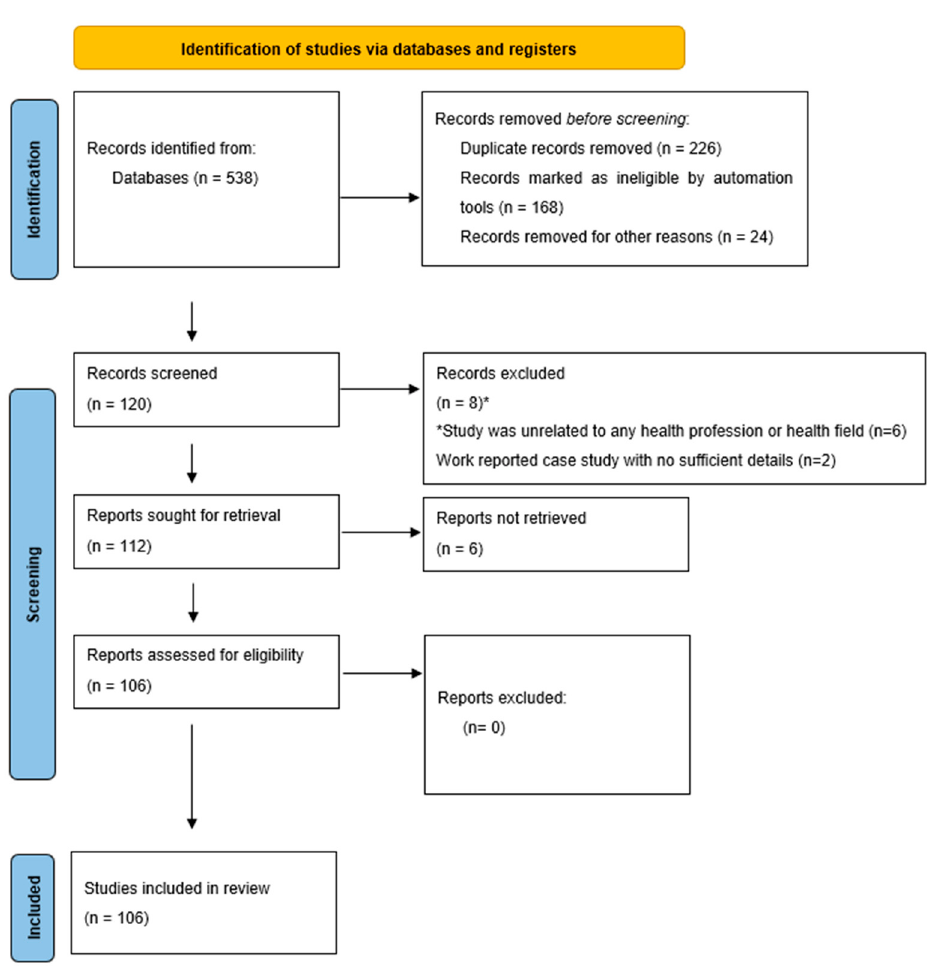
Figure 3. Flowchart based on the PRISMA statement.